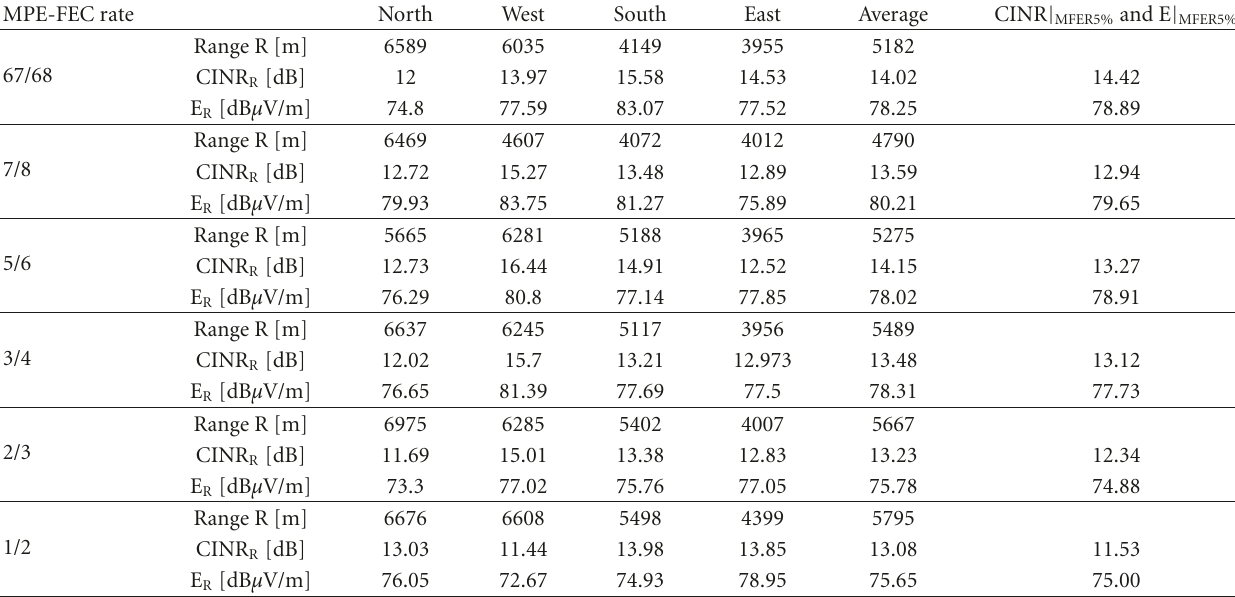
Table 2: Range R, corresponding CINR R and E R values for 95% valid reception, and MFER 5% values for routes along di ff erent